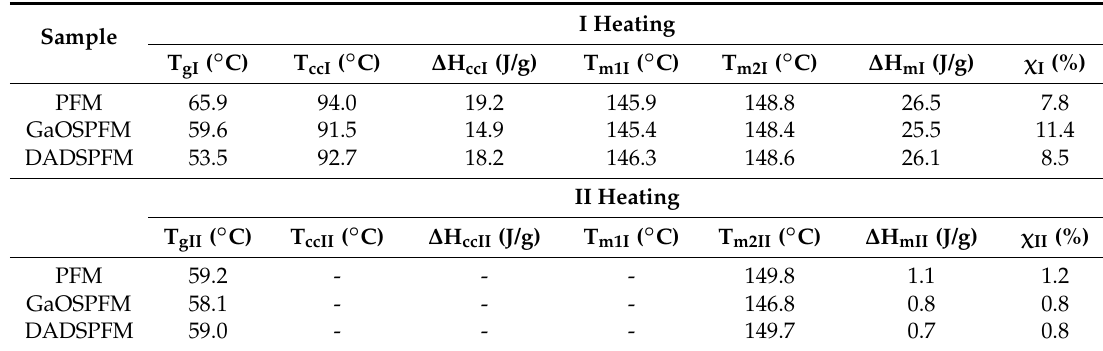
Table 2. Differential scanning calorimetry (DSC) data for PFM, GaOSPFM and DADSPFM.